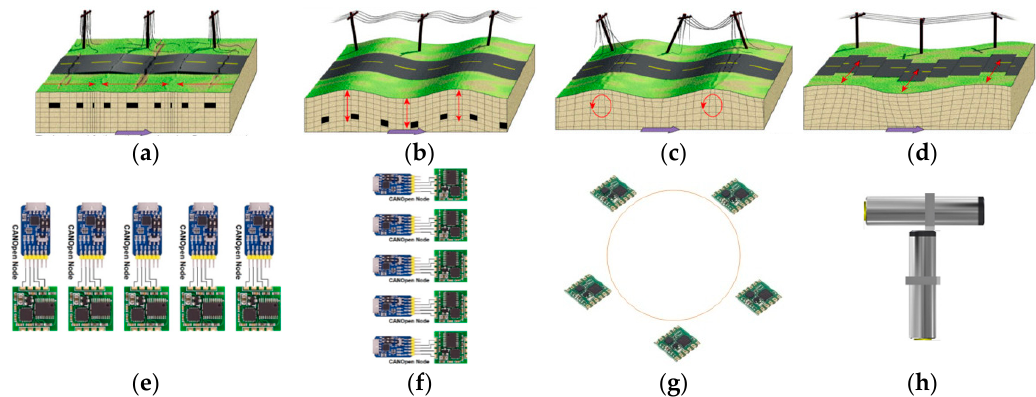
Figure 13. Realization of a SGBIN cluster topologies according to seismic wave ground motions as ( a ) P-wave ground motions; ( b ) S-wave ground motions; ( c ) R-wave ground motions; ( d ) L-wave ground motions; ( e ) SGBIN topology for P-wave detection; ( f ) SGBIN topology for S-wave detection; ( g ) SGBIN topology for R-wave detection; ( h ) SGBIN topology for L-wave detection.